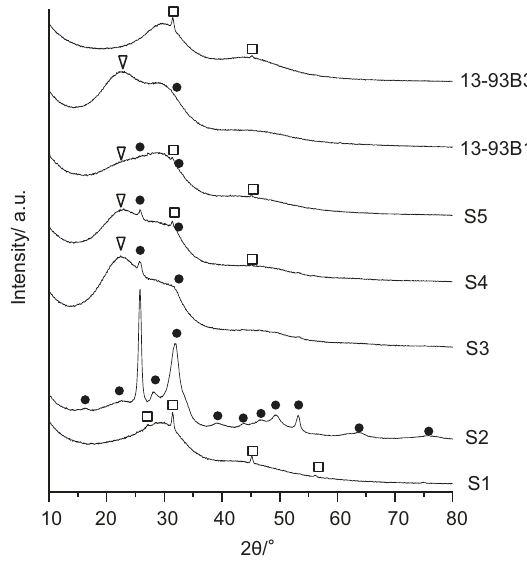
Fig. 6 Thin- fi lm XRD patterns of the surfaces of the glasses after soaking in SBF for 1 week. (cid:129) Apatite, ∇ Silica gel, □ NaCl Table 3 Surface change of glasses and ion concentrations in SBF